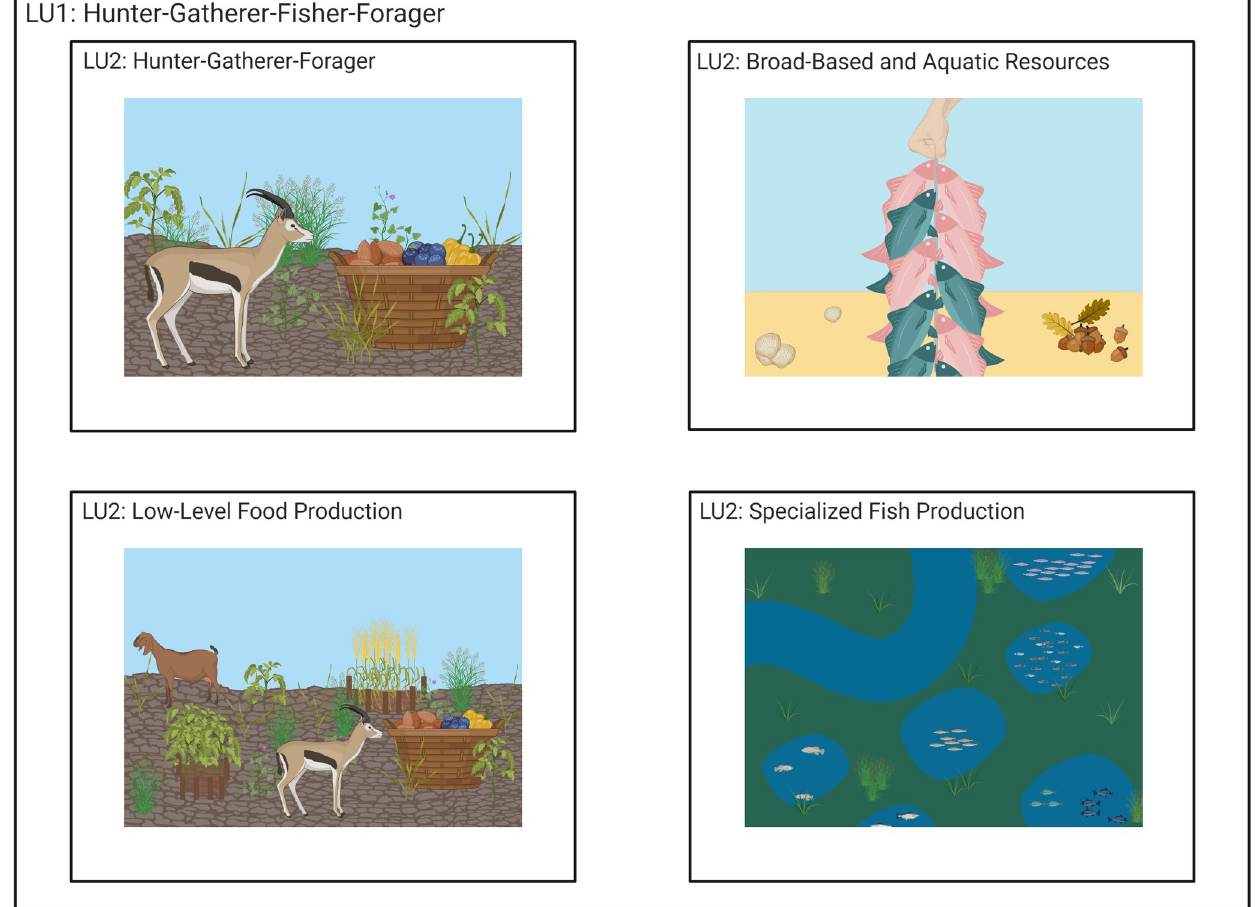
Fig 5. LU1-“hunter-gatherer-fisher-forager” visualized as several LU2 categories: LU2-“hunter-gatherer-forager” is represented by wild resources gazelle and wild gathered nuts, fruits, seeds and berries. LU2-“broad-based and aquatic resources” is shown by a line of caught fish, shells and a collection of gathered nuts. LU2-“low-level food production” is represented by gazelle and wild gathered nuts, fruits, seeds and berries, and a small number of domesticated resources including deer and weedy/semi-domesticated pulses and cereals. LU2-“specialized fish production” is shown through ponded resources in which fish have been collected and placed for future use. Created with BioRender.com, under a CC BY license, with permission from Biorender, original copyright 2020.